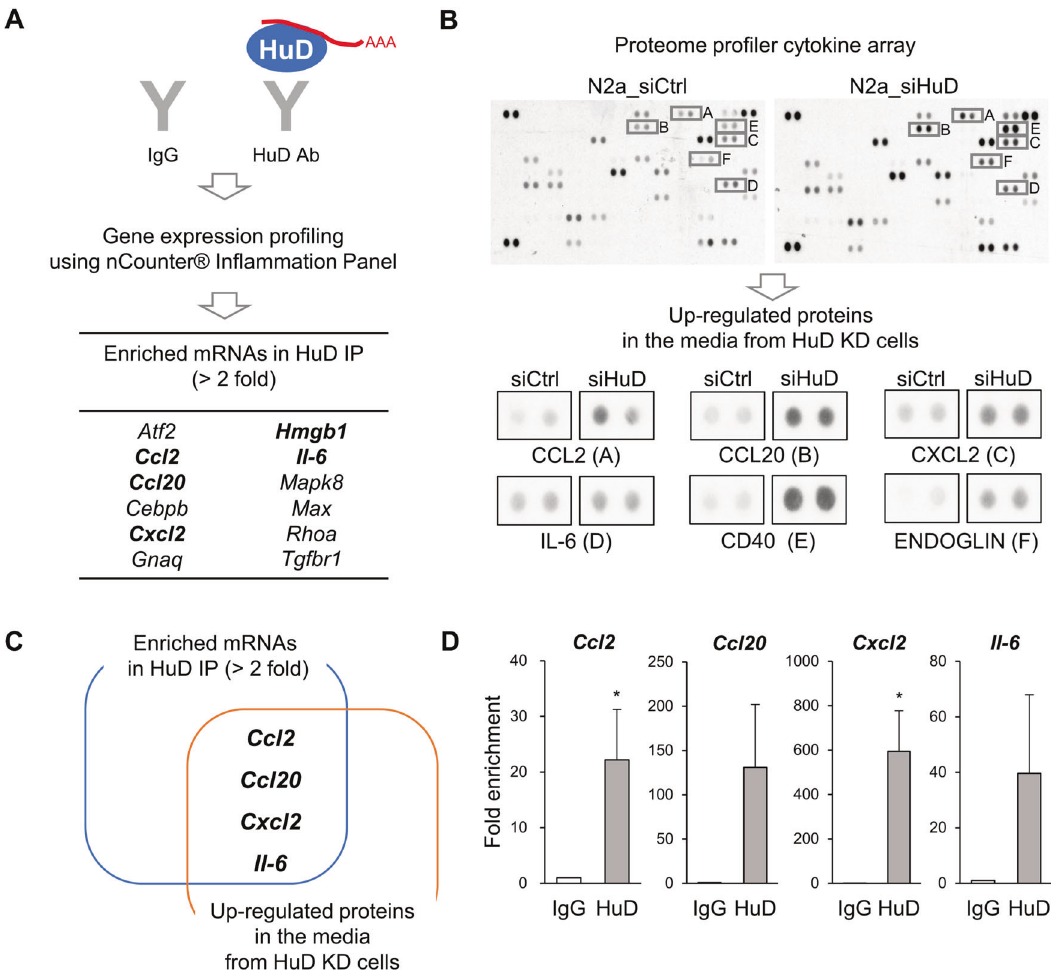
Fig. 2 Identi fi cation of molecular targets of HuD. A The mRNAs that interact with HuD were isolated via RNA immunoprecipitation and analyzed via gene expression pro fi ling using the NanoString nCounter ® In fl ammation Panel. Enriched mRNAs in HuD IP (>2-fold) compared to control IgG IP are listed in the table and senescence-associated secretory phenotype (SASP) mRNAs are shown in bold. B N2a cells were transiently transfected with control siRNA or HuD siRNA and the secretory proteins in the culture media were analyzed by western blotting using the Proteome Pro fi ler Mouse XL cytokine array. The differential expression analysis of secretory proteins revealed six proteins, including CCL2, CCL20, CXCL2, IL-6, CD40, and ENDOGLIN, which were identi fi ed as upregulated ones in the media from HuD knockdown cells. C Four candidates that not only bind to HuD but also are upregulated by HuD knockdown were determined as putative targets of HuD; Ccl2 , Ccl20 , Cxcl2 , and Il-6 . D Interaction between HuD and its putative targets was validated by RNA IP followed by RT-qPCR using anti-HuD and control IgG antibodies. Gapdh mRNA was used for normalization. Data indicate the mean ± SEM from three independent analyses. The statistical signi fi cance of the data was analyzed via Student ’ s t -test; * p <